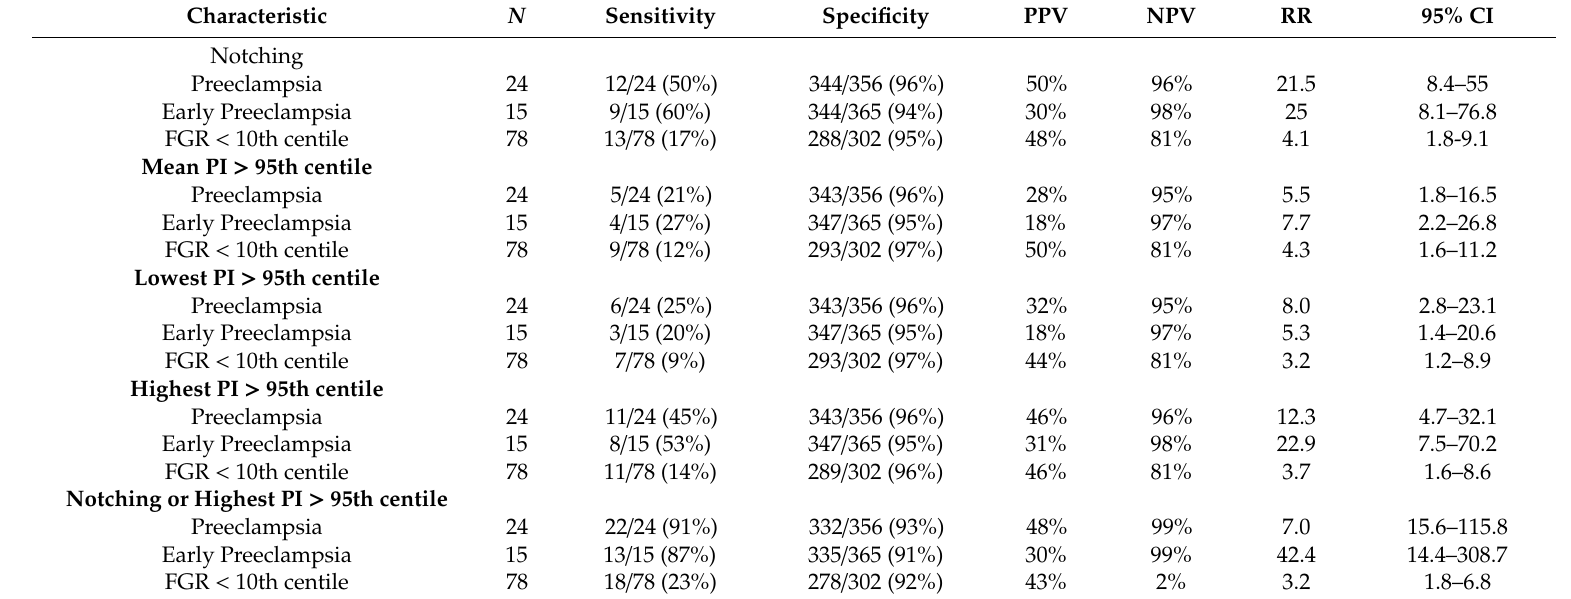
Table 3. Screening characteristics for notching, mean, lowest, highest PI above the 95th centile and combination of notching and the highest PI above the 95th centile.